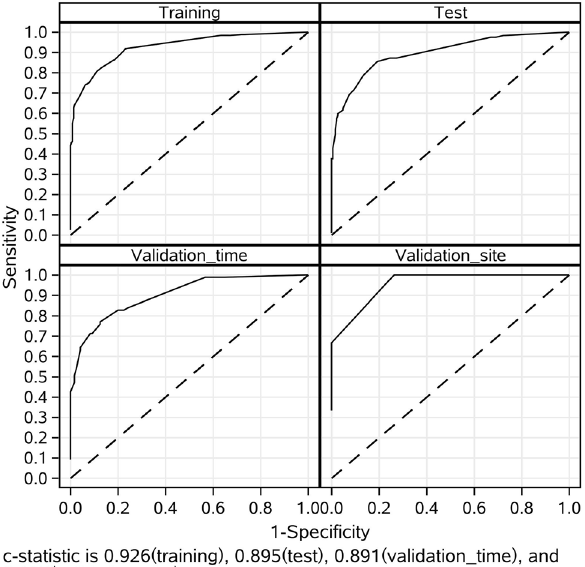
Figure 3. ROC analyses for the evaluation and validation of the risk model in the training, test, validation_ time, and validation_site samples. Model performance in the test, validation_time, and validation_site samples was comparable to that in the training sample. The overall C statistics were 0.926 (95% CI 0.891–0.924), 0.895 (95% CI 0.855–0.928), 0.891 (95% CI 0.848–0.932), and 0.827 (95% CI 0.455–1.000) for the training, test, validation_time, and validation_site samples,